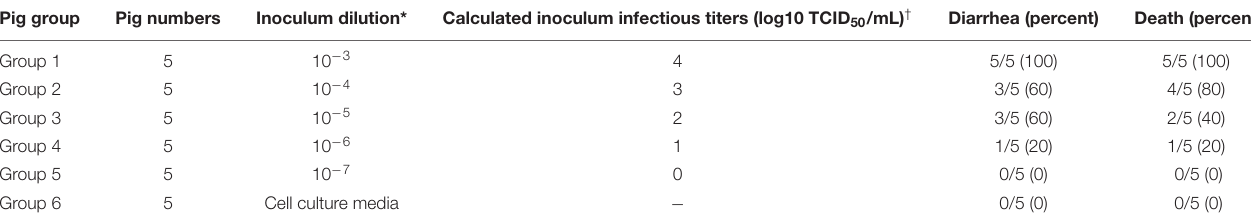
TABLE 1 | Summary of pig groups, group numbers, inocula, and pig diarrhea and death outcomes after inoculation. Pig group